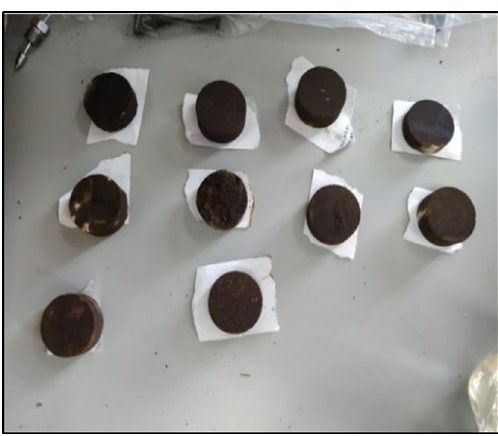
Fig. 1 The prepared samples for measuring the contact angle